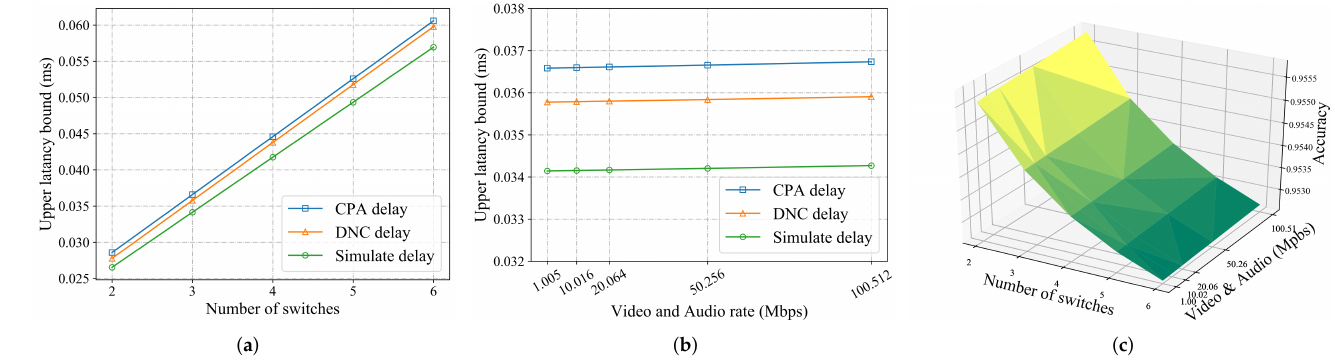
Figure 5. Multi-flow with multi-switch: ( a ) end-to-end delay of target flow versus number of switches (at Video rate of 1 Mbps and audio rate of 5 Kbps), ( b ) end-to-end delay of the target flow versus the arrival rate of the interfering flow (when N = 3), and ( c ) interference flow rates and number of switches versus